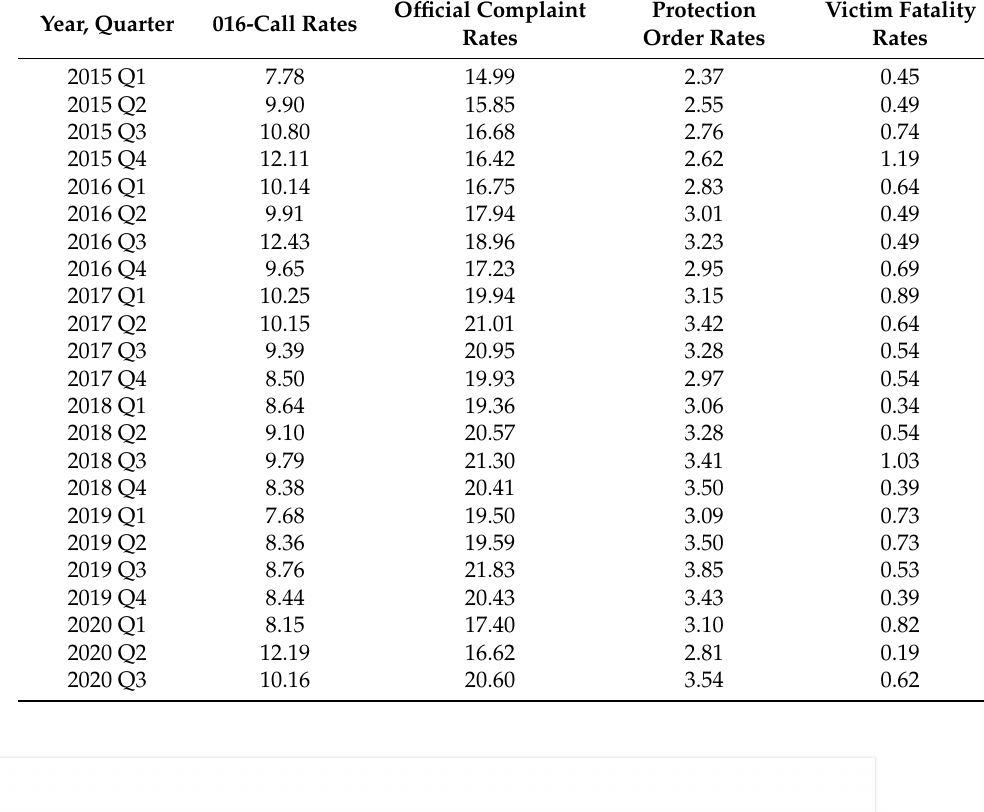
Table 1. Rates of 016-calls, protection orders, and official complaints per 10,000 women aged 15 or over, and mortality data per 1,000,000 for violence against women by their partners, per quarter, 2015–2020.